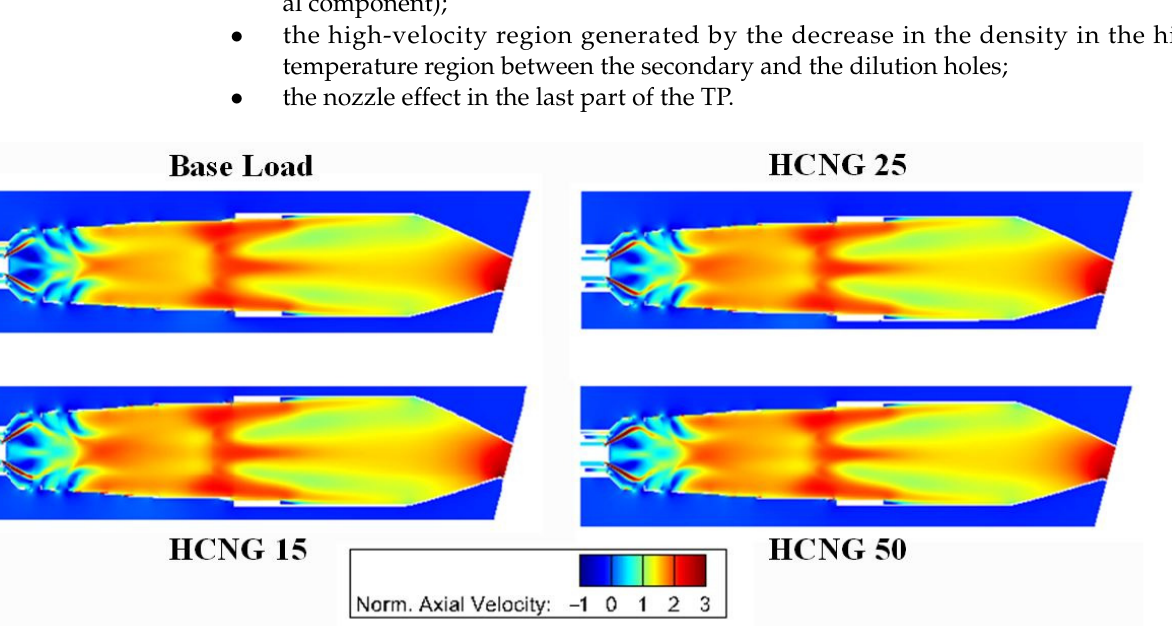
Figure 12. Axial velocity contours in slice 2.